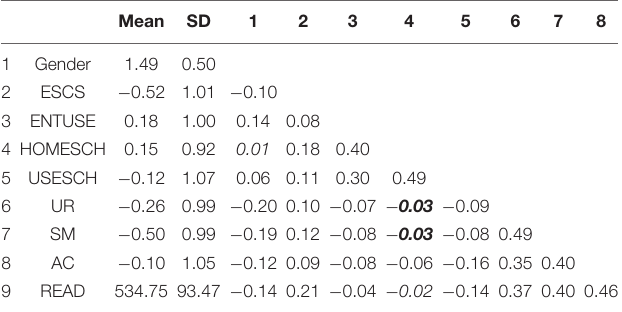
TABLE 4 | Descriptive statistics and correlations of variables involved in present study.